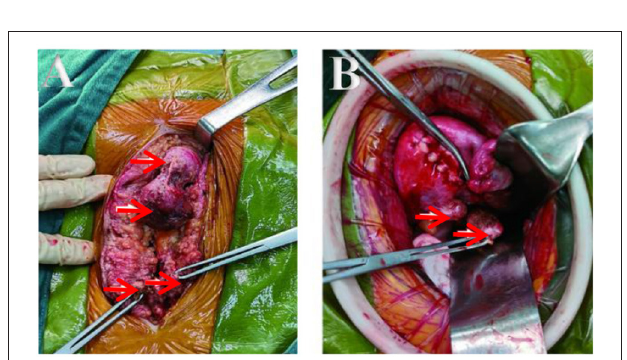
FIGURE 5 | Microscopic observation. (A) Pathology microscopically seen for the first surgery, in rich cell type with red degeneration and (B) Immunohistochemical finding: SMA( + ), Desmin ( + ), myogenin(–), Ki-67( + 2%), HMB-45(–), CD34(–), CD117(–), Dog1(–), ER(–), PR(2 + ) (H&E, 100 × ).